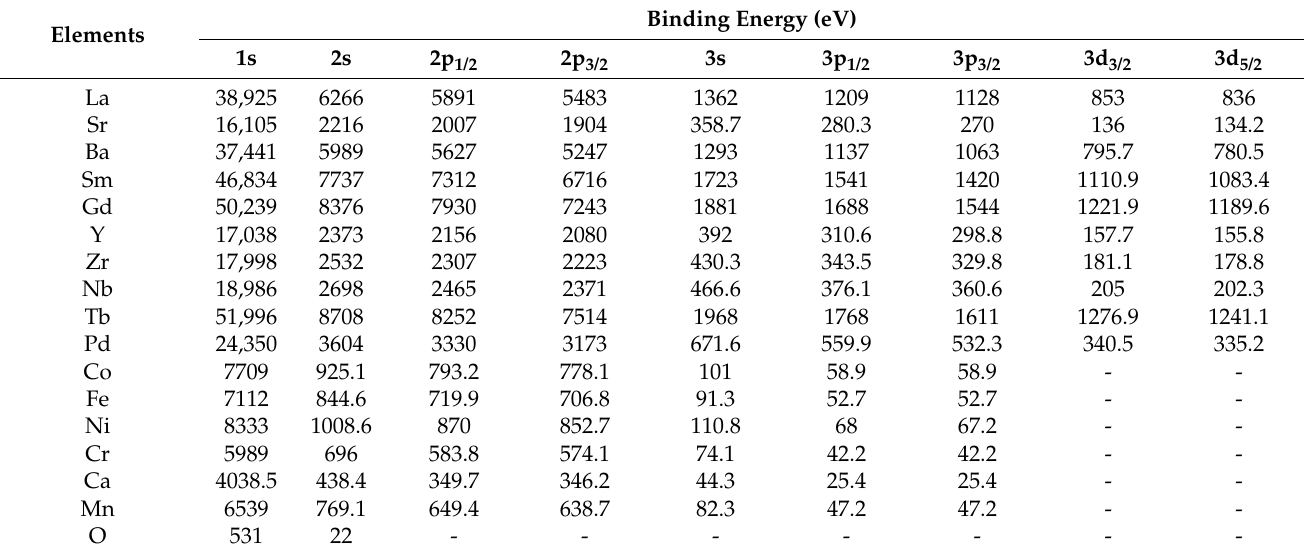
Table 1. Binding energy of electrons for selected elements in their elemental